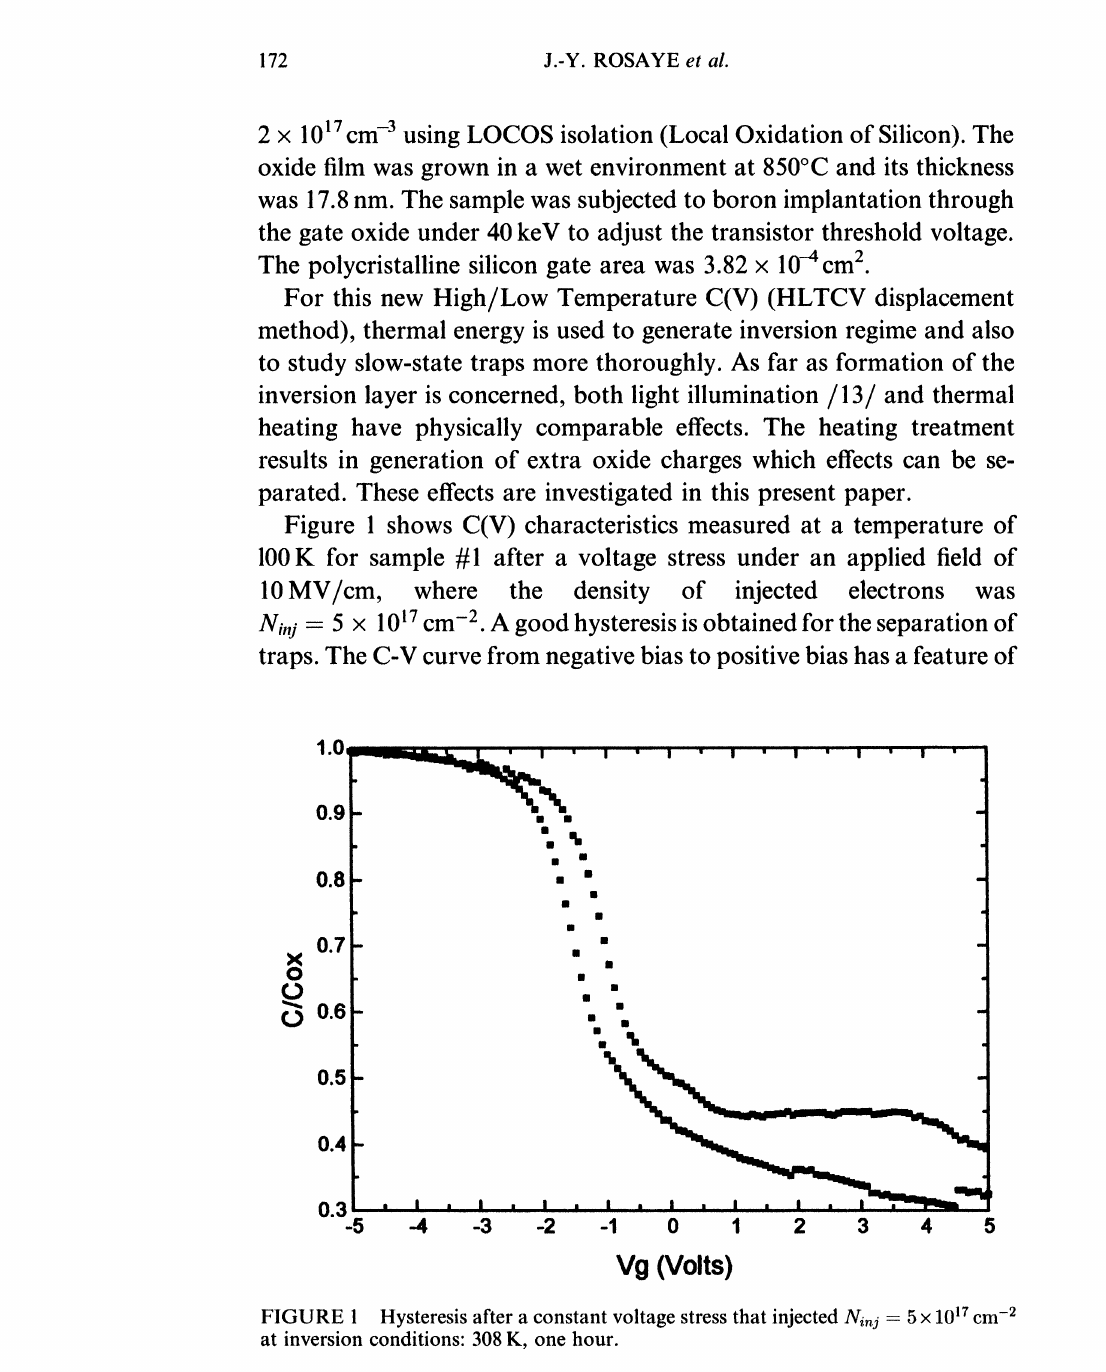
Vg (Volts) FIGURE Hysteresis after a constant voltage stress that injected Ni, 5 x 1017 cm -2 at inversion conditions: 308 K, one